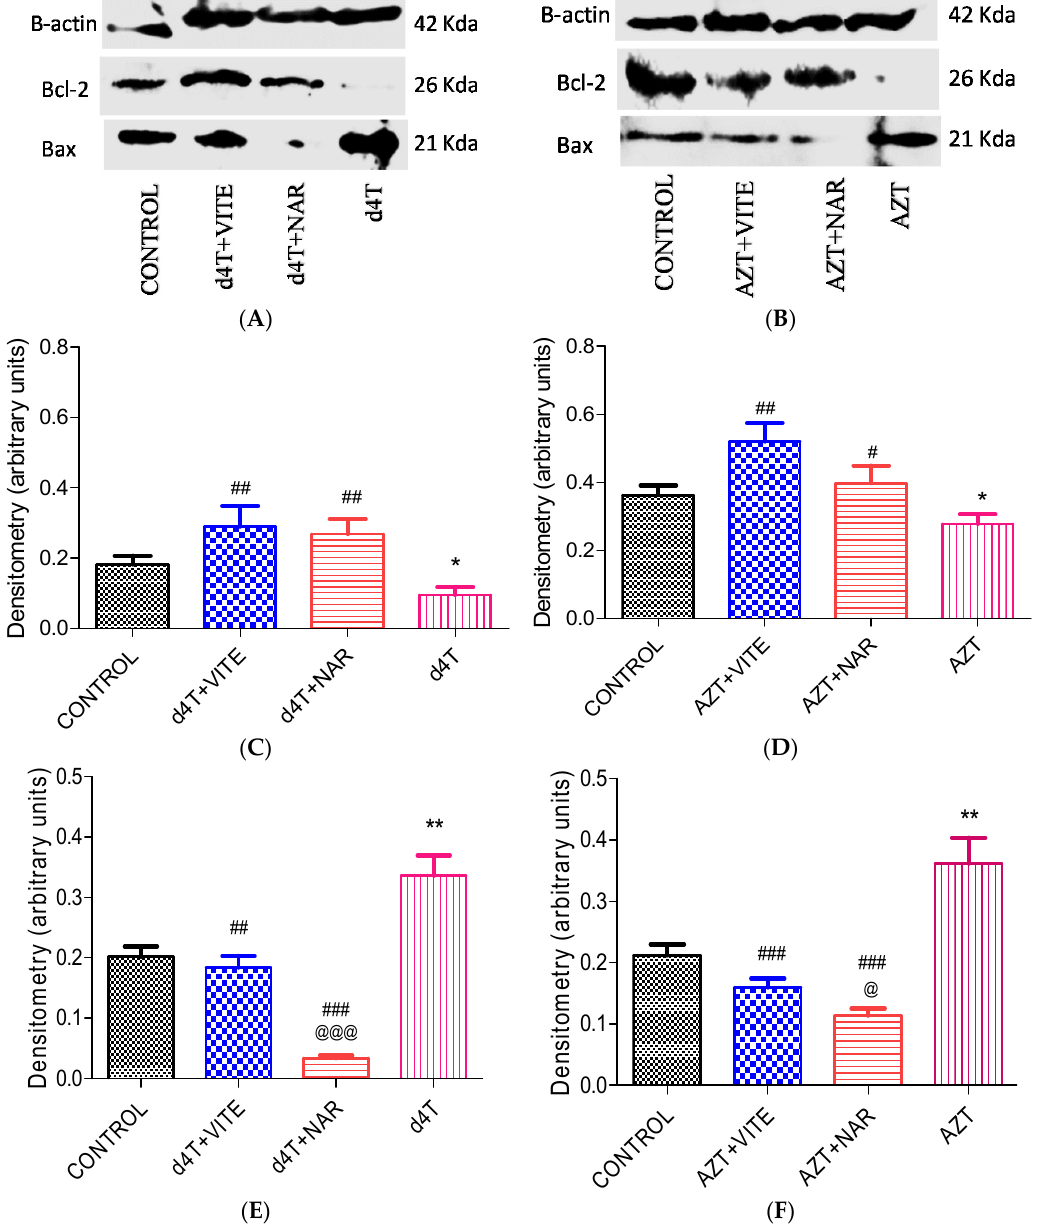
Figure 9. Bax and Bcl-2 protein expression following 56 days of NRTI treatment. ( A ) and ( B ) show Bax, Bcl-2 and beta actin protein expression whilst ( C ), ( D ), ( E ) and ( F ) show the densitometry scans of the respective proteins normalized to the house-keeping protein (beta actin) following 56 days of drug administration; ( C ) and ( E ) d4T- (* p < 0.05; ** p < 0.01 compared to control and ## p < 0.01; ### p < 0.001 compared to d4T); ( D ) and ( F ) AZT- (* p < 0.05; ** p < 0.01 compared to control and # p < 0.05; ## p < 0.01; ### p < 0.001 compared to AZT). @@@ p < 0.001 and @ p < 0.05 compared to vitamin E in d4T and AZT-treated rats, respectively.